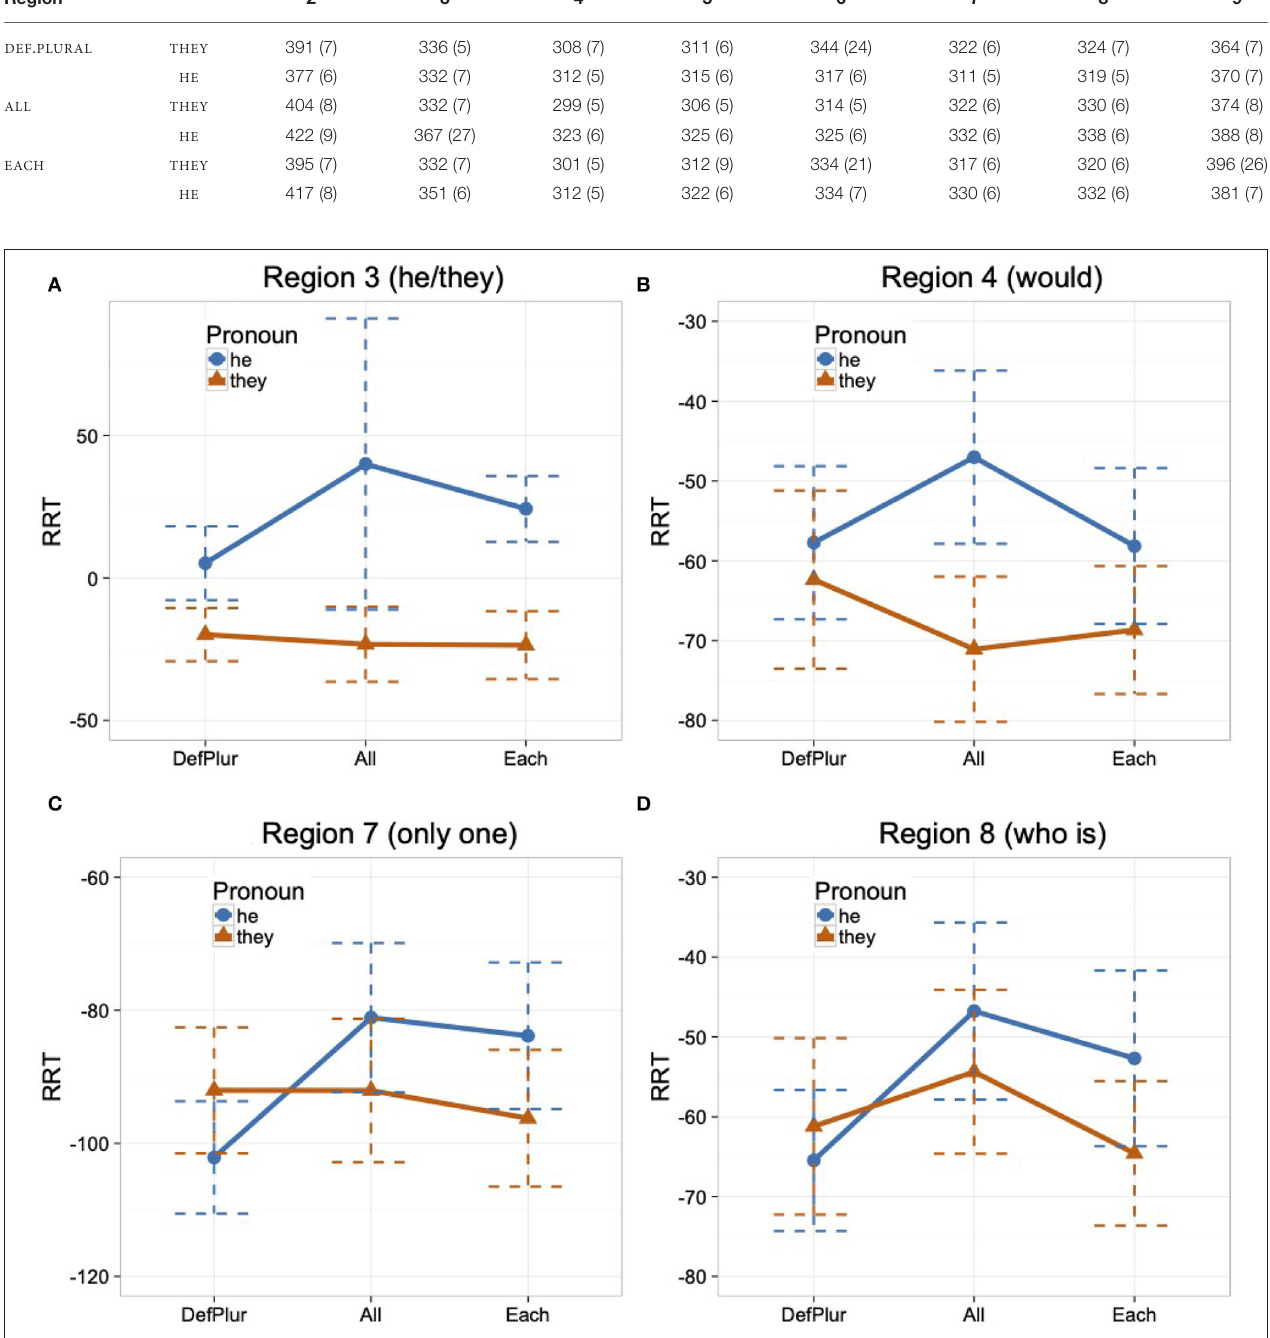
TABLE 7 | Mean raw reading times (SE) in ms, Experiment 4. Region